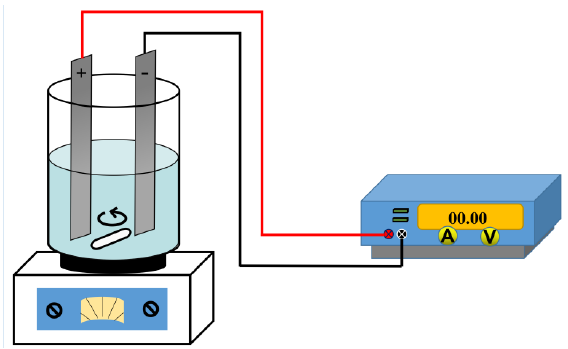
Figure 1. The experimental apparatus of enhanced extracted by electric field.